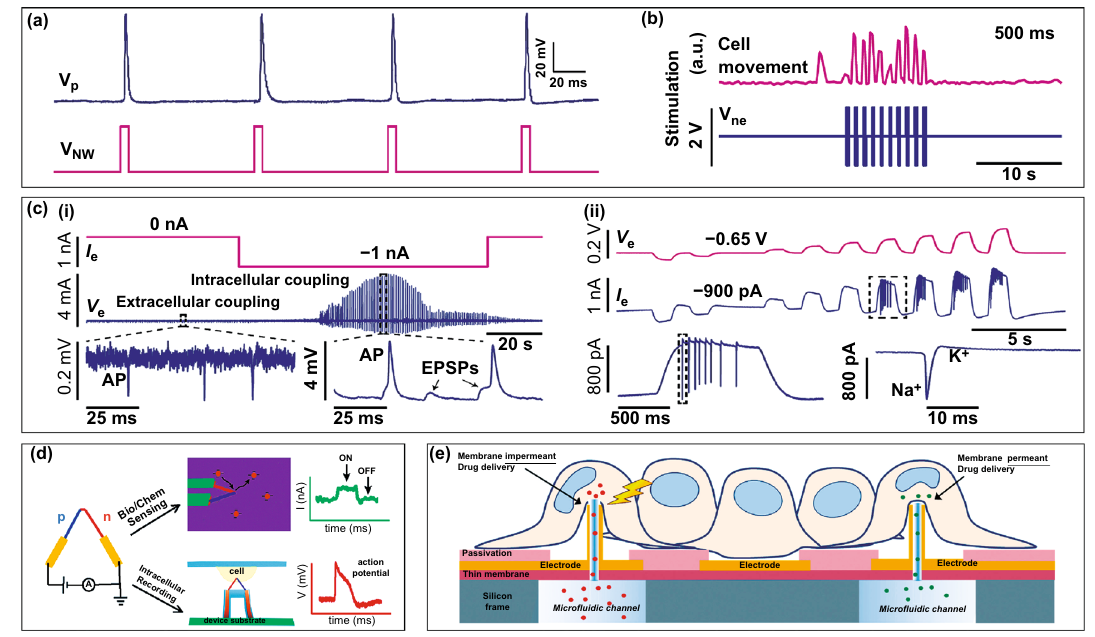
Fig. 7 Multifunctional in-cell nanoelectronics. a Voltage pulses injected through vertical nanowire electrodes to induce action potentials of neurons. Reproduced with permission from Ref. [89]. Copyright 2012, Nature. b Current pulses injected through vertical nanowire electrodes to change the beating frequency of cardiomyocytes. Reproduced with permission from Ref. [92]. Copyright 2017, Nature. c (i) Current injection and potential recording in the pCC configuration. (ii) Voltage injection and current recording in the pVC configuration. Reproduced with per- mission from Ref. [94]. Copyright 2020, Nature. d Schematic illustration of p–n diode device for intracellular recording and bio/chem sensing. Reproduced with permission from Ref. [104]. Copyright 2012, American Chemical Society. e Schematic illustration of the biosensor for selec- tive intracellular delivery and intracellular recordings. Reproduced with permission from Ref. [152]. Copyright 2018, Royal Society of Chemis-